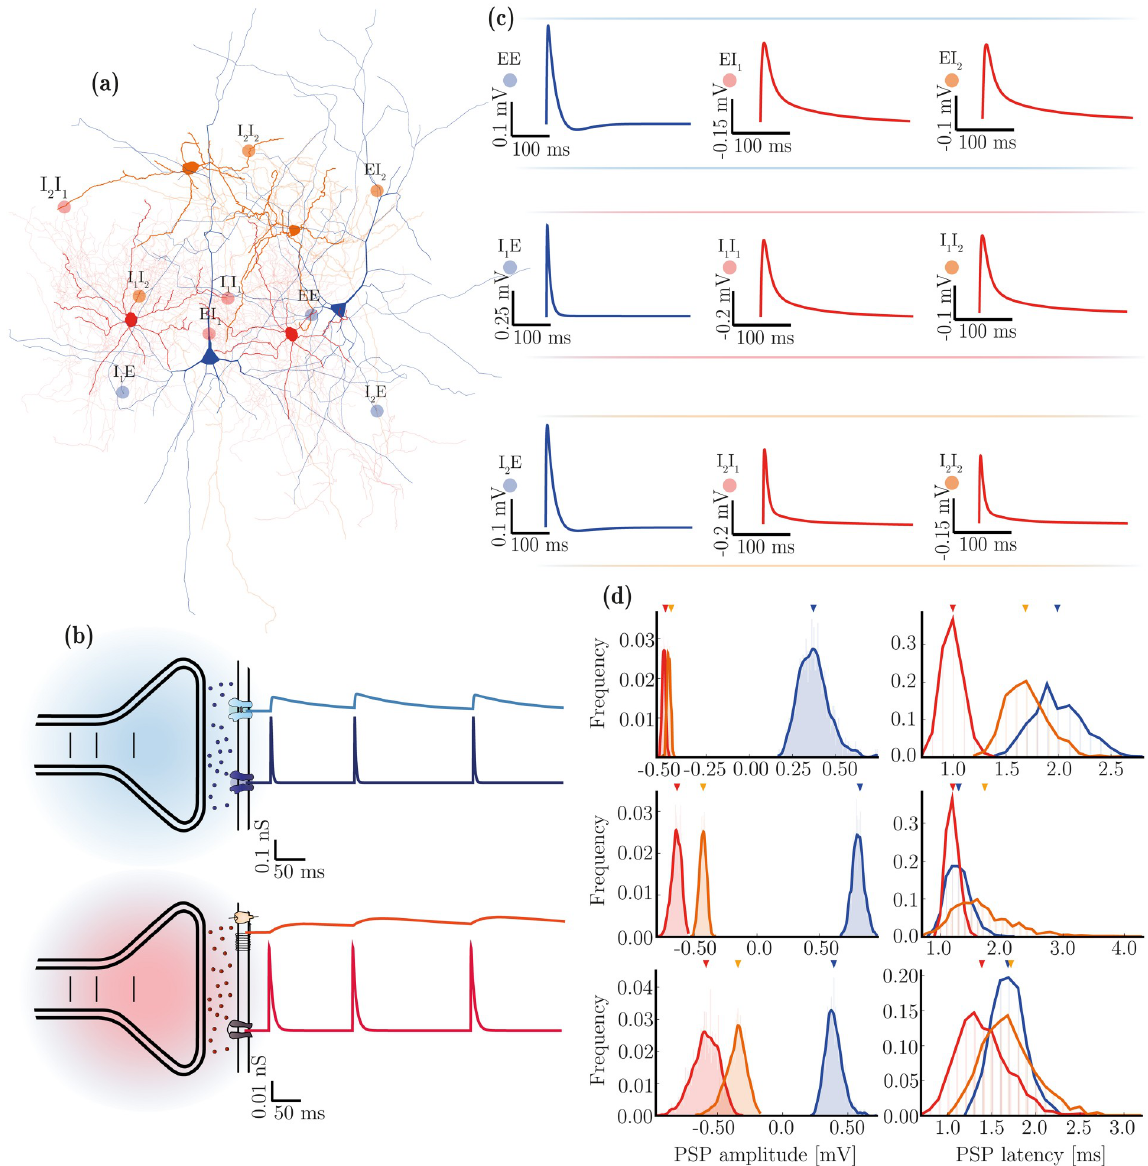
Fig 2. Diversity of synaptic transmission in the microcircuit. ( a ) Illustration of the three neuron and nine synapse types considered in this study. ( b ) Characteristics of synaptic transmission in excitatory (blue) and inhibitory (red) synapses, comprising fast and slow components. ( c ) Kinetics of spike-triggered PSPs dependent on pre- and post-synaptic neuron type and determined by the specific receptor kinetics and composition in the postsynaptic neuron. The depicted traces are the PSPs at rest in E neurons (top row) and at a fixed holding potential of − 55 mV for inhibitory neurons (I 1 : middle row, I 2 : bottom row), as a function of receptor composition and correspond to the values reported in Table 2 (last column). ( d ) Distributions of PSP amplitudes and latencies after rescaling (by w syn and d syn , respectively, see Table 3) in the homogeneous (top arrows) and heterogeneous (distributions) conditions, for synapses onto E (top), I 1 (middle) and I 2 (bottom) neurons. Note that the latency distributions are discrete in that for technical reasons, they can only assume values that are a multiple of the simulation